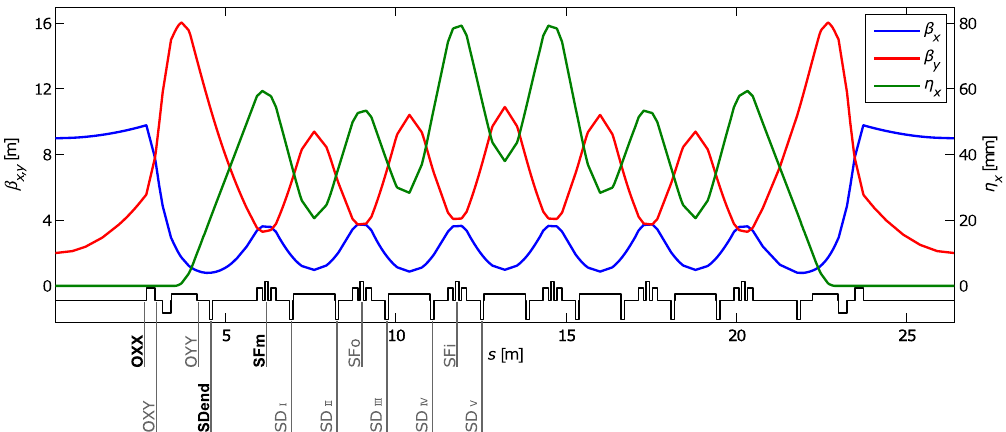
FIG. 1. Design optics of the MAX IV 3 GeV storage ring in one achromat. The design vertical dispersion is zero everywhere. The positions of the magnets are indicated at the bottom in black. The positions and names of sextupole and octupole magnets, equipped with auxiliary coils to generate skew quadrupole gradients, are indicated below. The sequence of magnets repeats mirror-symmetrically throughout the second half of the